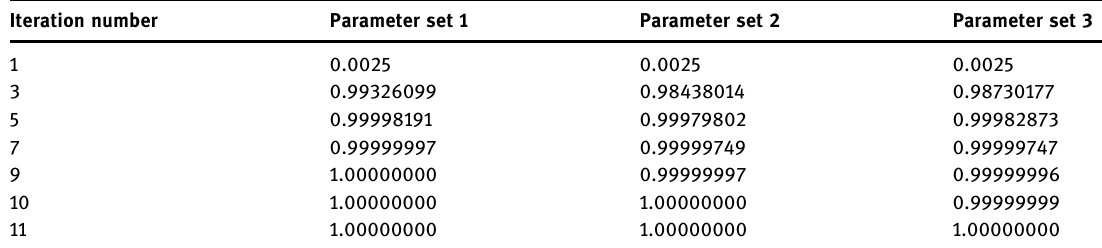
Table 1: Values of iteration for di ff erent sets of parameters